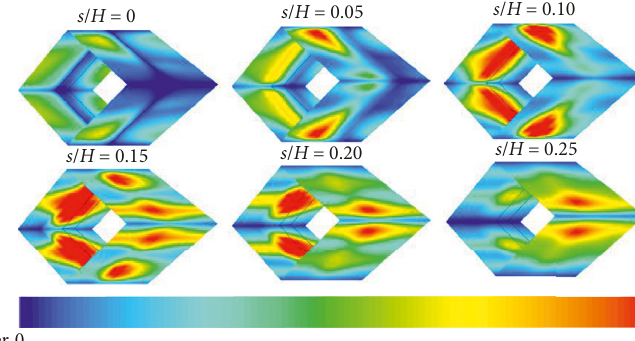
Figure 13: Nu x of the heat exchanger square duct installed with the 45